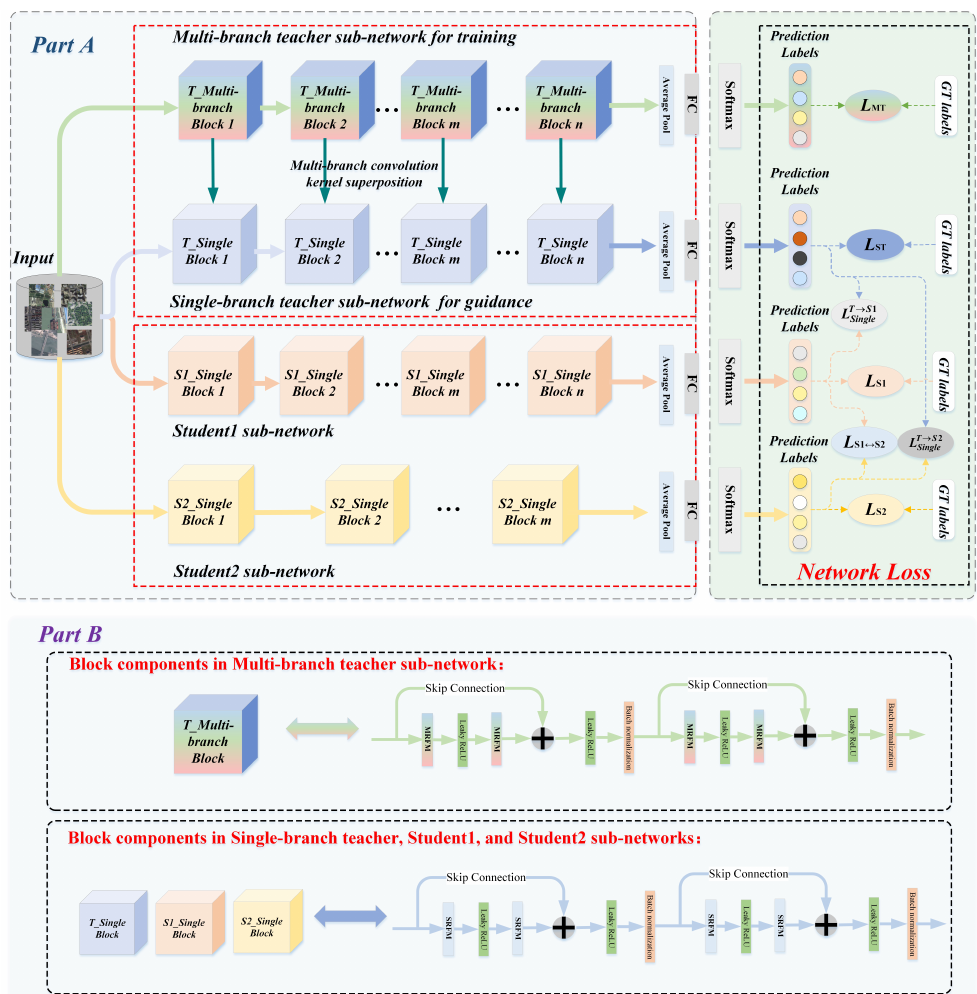
Figure 1. Illustration of the collaborative consistency distillation framework. For the network input, deep semantic features of the remote sensing image scene classification can be obtained in two aspects: On the one hand, we used the teacher sub-networks to extract deep semantic features for guiding the student sub-networks to extract more refined classification feature information. On the other hand, the classification feature information was reinforced by mutual supervision among student sub-networks to enable the student sub-networks to obtain higher classification results.